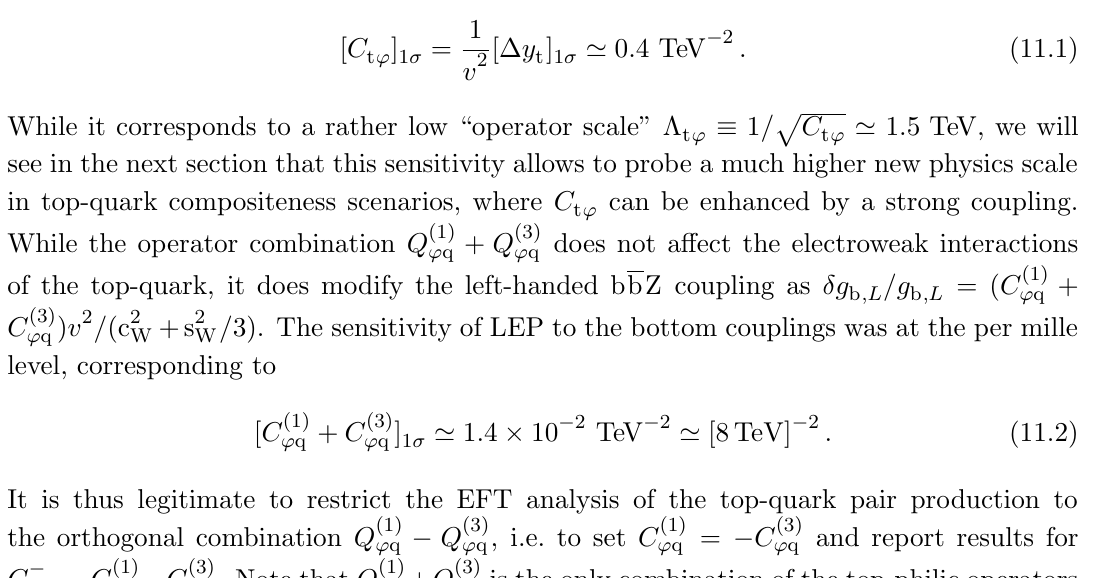
, (cid:27) and the set FB tt